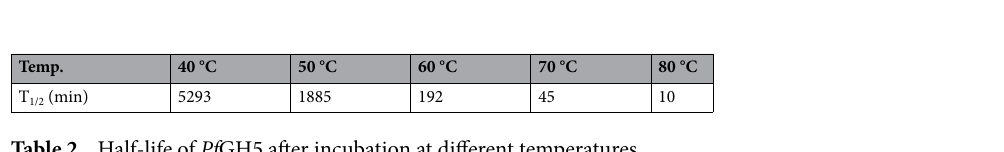
Table 2. Half-life of Pf GH5 after incubation at different temperatures.